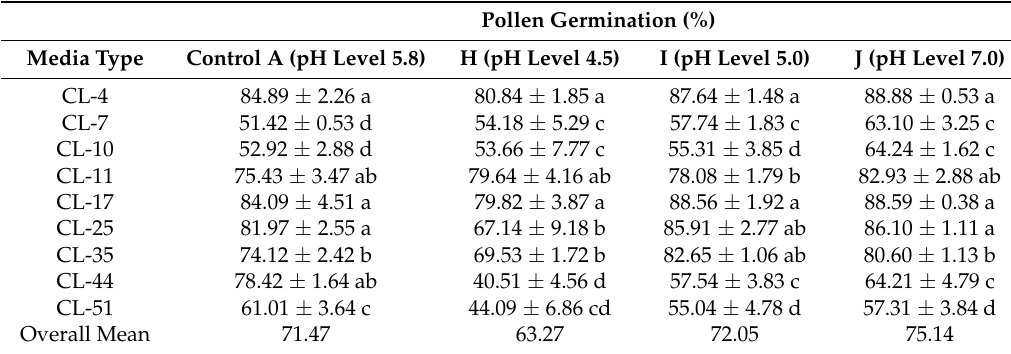
Table 6. Effects of pH level on pollen